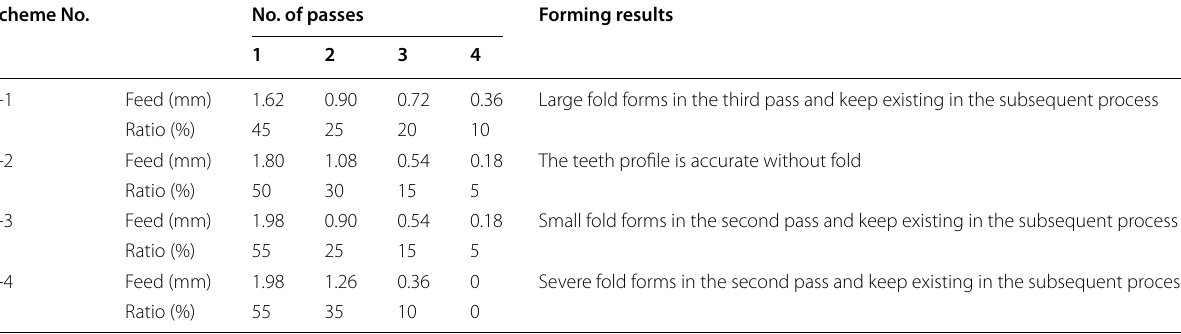
Table 2 Per-pass forming depth and simulation results of the final quality Scheme